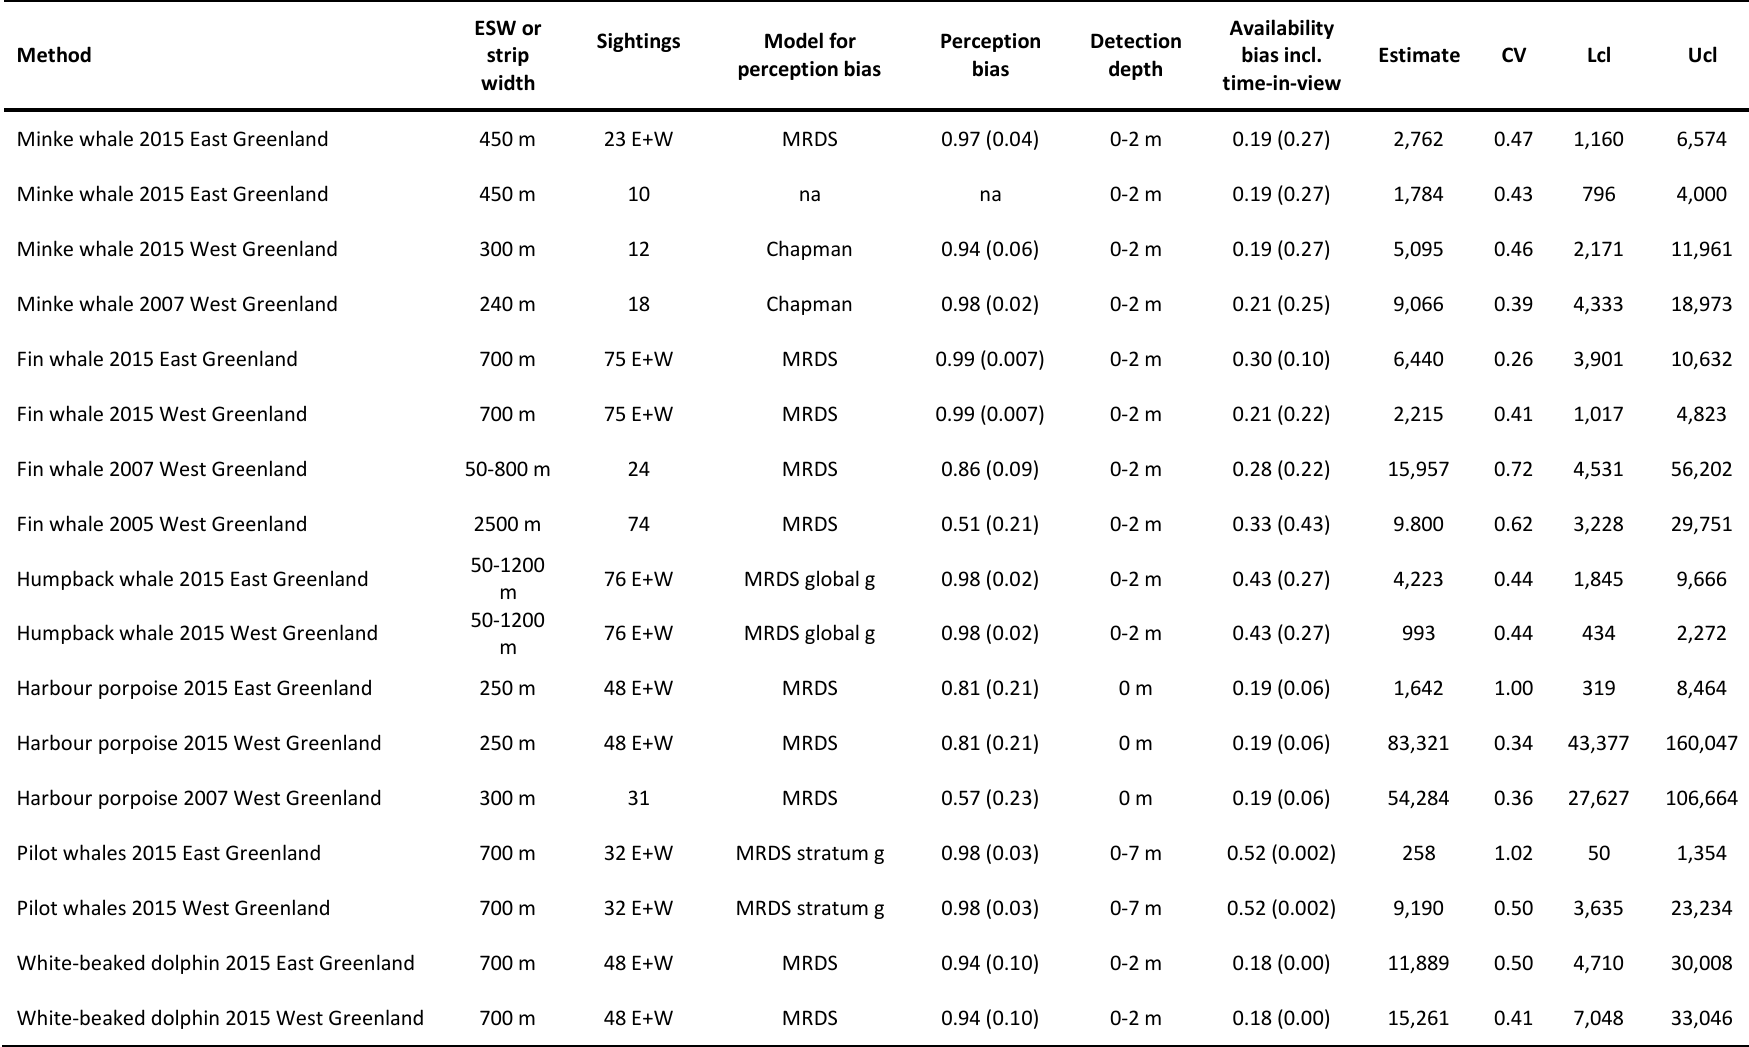
Table 7. Fully corrected abundance estimates for baleen whales, harbour porpoises, pilot whales and white-beaked dolphins in West and East Greenland in 2005, 2007 and 2015. ESW is the effective search width and N is the number of sightings. All estimates are based on mark recapture distance methods except for the two minke whales estimates in West Greenland where strip census estimates with uniform detection functions were used due to the low number of sightings. Lcl and Ucl is lower and upper 95% confidence limits. E+W indicate that sightings from both East and West Greenland were used for deriving the detection